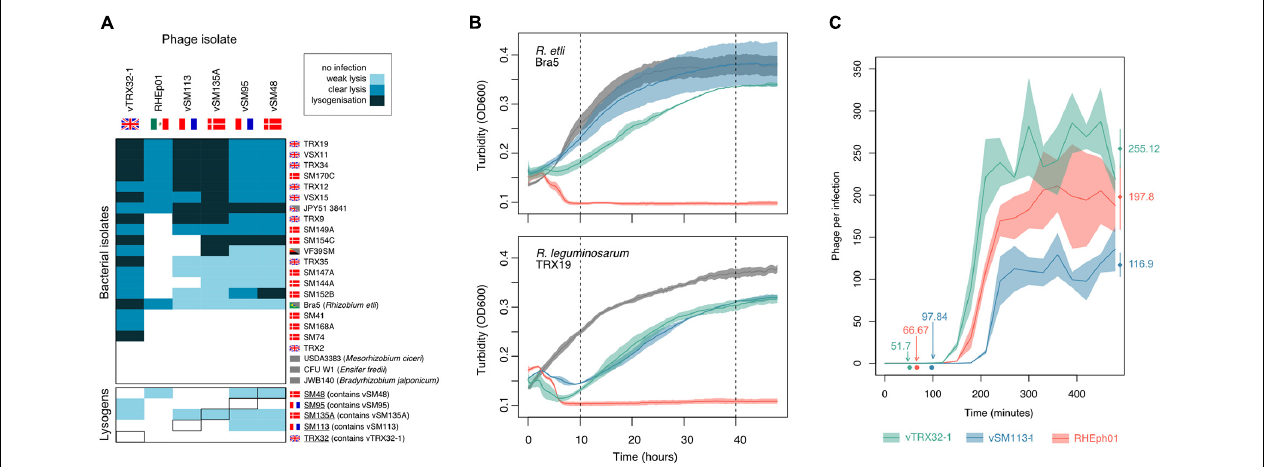
FIGURE 2 | Phage growth characteristics. (A) Infection host range. Six phages were challenged against bacterial strains from the same isolation sites as well as type strains of more distantly related Rhizobia. Strain origin is denoted by flag with gray blocks indicating lab strains. Bacterial strains in the left-hand box are the original lysogenic hosts. Infectivity was graded as weak lysis (turbid clearing in high titer spots), clear lysis (clear high titer spots and individual plaques at low dilutions), and lysogenization (clear high titer spot at day 1, subsequently becoming turbid). (B) Phage virulence effects on growth of two Rhizobium hosts, R. etli Bra5 (upper panel) and R. leguminosarum TRX19 (lower panel). The turbidity of bacterial cultures containing phage at 10:1 bacterial:phage ratio was observed overtime. Virulence (lysis) was estimated from reduction in bacterial growth relative to the phage free control at 10 h post-infection and overall impact of phages (including lysis and recovery) measured at 40 h post-infection. Lines shown are averages across 3 replicates with area denoting standard error. (C) Lytic phage reproduction rate from bacterial infection. Phage replication was assayed on R. leguminosarum host TRX19 using the one-step growth curve method. For each phage latent time (i.e., incubation period) and burst size (number of phages produced per infection) were estimated from growth curve analysis and shown and round points and diamond points, respectively ( n =